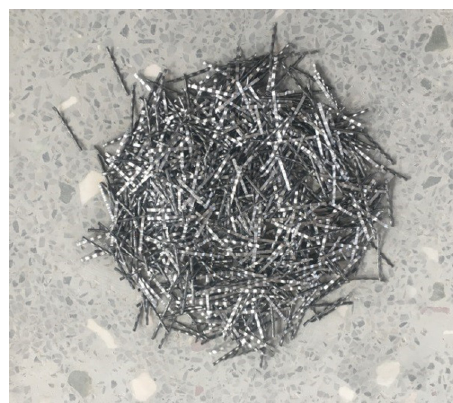
Figure 2: Image of SFs.